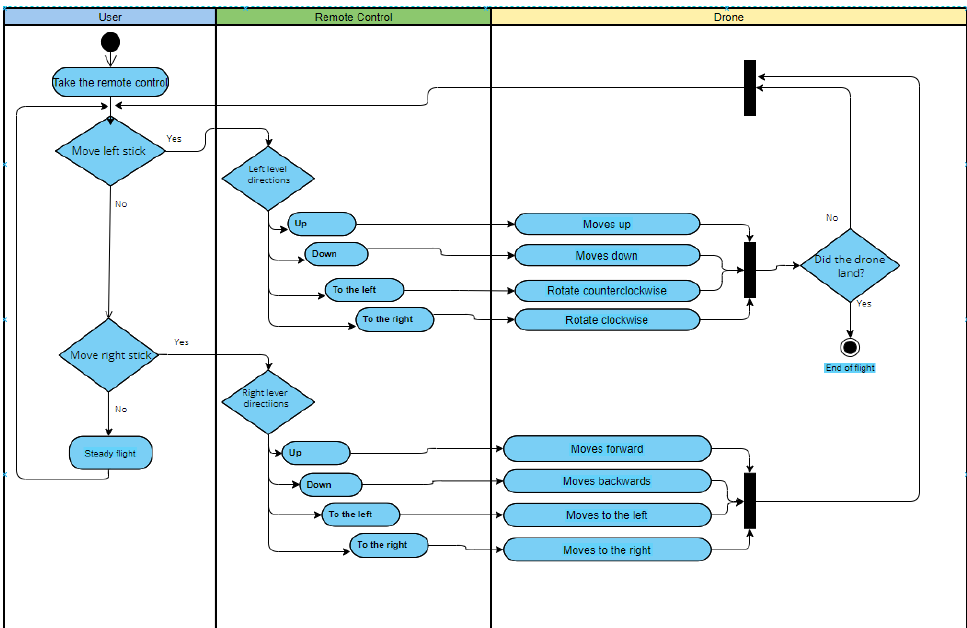
Figure 13. Activity diagram of drone actions based on remote control input commands.